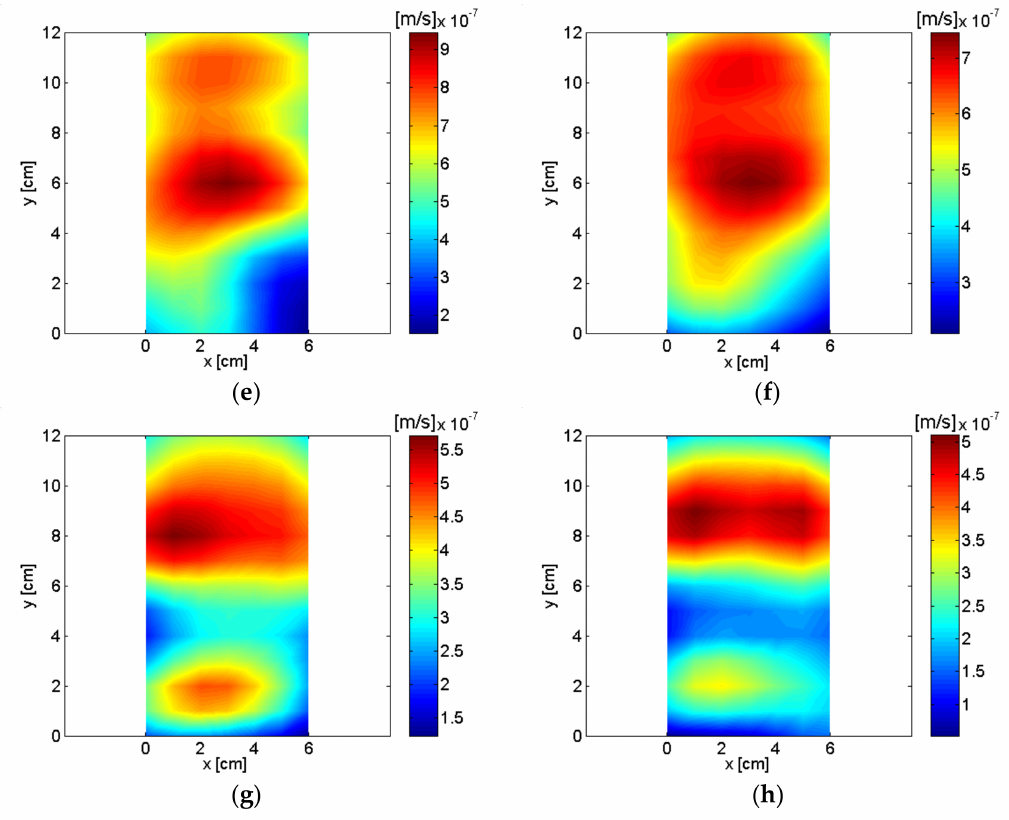
Figure 12. Reconstructed particle velocity of air compressor: ( a ) 56 Hz; ( b ) 356 Hz; ( c ) 836 Hz; ( d ) 1016 Hz; ( e ) 4132 Hz; ( f ) 5036 Hz; ( g ) 6888 Hz; ( h ) 8264 Hz.